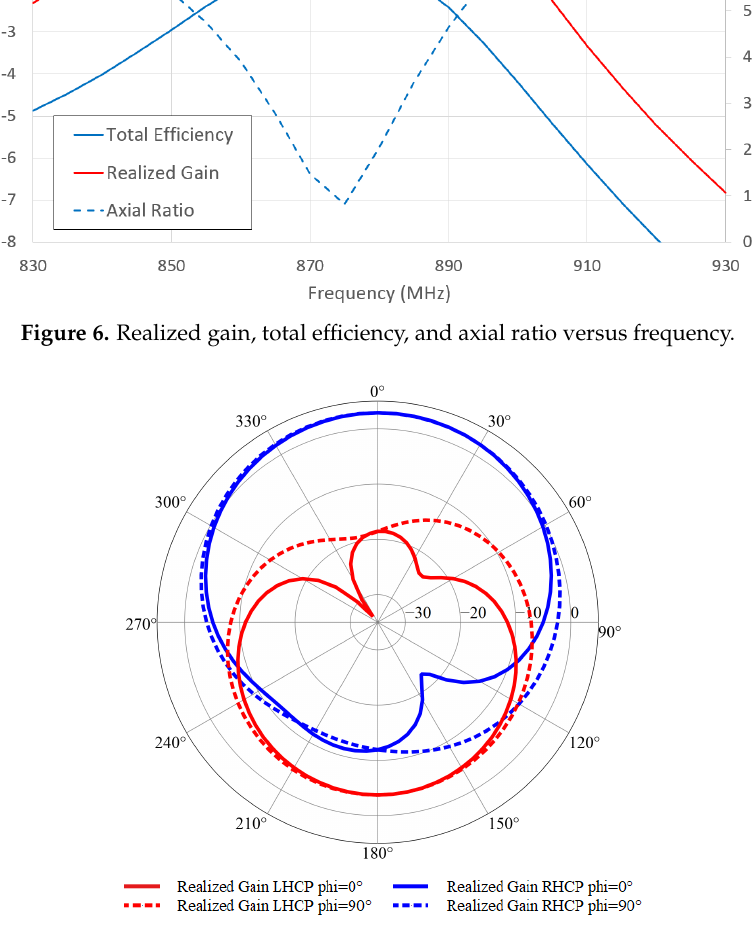
Figure 7. Simulated Left-Handed Circularly Polarized (LHCP) and Right-Handed Circularly Polarized (RHCP) Gain versus theta for phi = 0 ◦ and 90 ◦